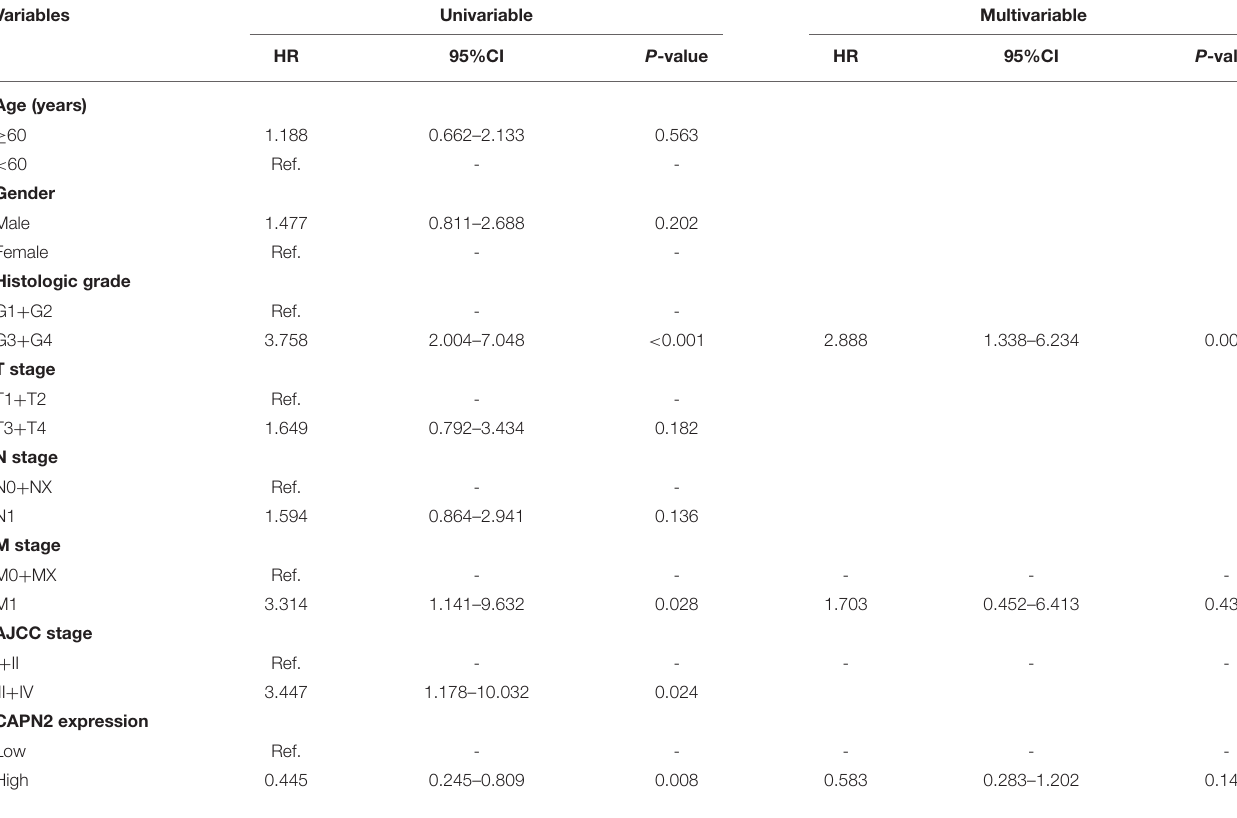
TABLE 2 | Univariable and multivariable Cox analysis of CAPN2 expression for OS.